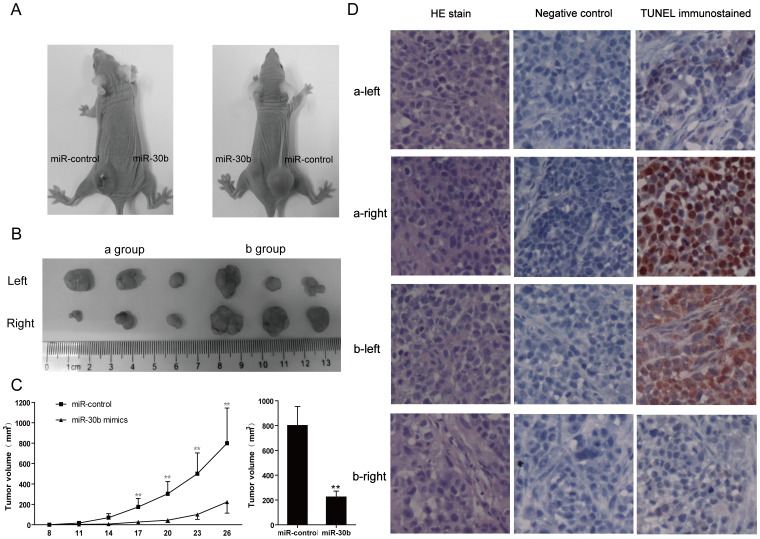
miR-30b suppresses tumorigenicity and promotes cell apoptosis in vivo.(A) Effect ofmiR-30b on tumor formation in vivo xenograft mode. miR-control- and miR-30b-transfected SGC-7901 (1×106) were suspended in 100 µl PBS and then injected subcutaneously into either side of the posterior flank of the same female BALB/c athymic nude mouse. Two representative tumor-bearing mice after 4 weeks inoculation were shown. (B) The significant differences of tumor volume between miR-control group and miR-30b group from 6 mice. (C) The tumor volume was measured every three days after injection of SGC-7901 cells with treatment as described in A, and the tumor growth curve was shown. The difference of tumor size between miR-control group and miR-30b group was statistically significant, **P<0.01. (D) The tumors were harvested at 26 days from two sides of the posterior flank of the same mouse, apoptosis in situ were measured by TUNEL. All data above are representative at least three independent experiments.